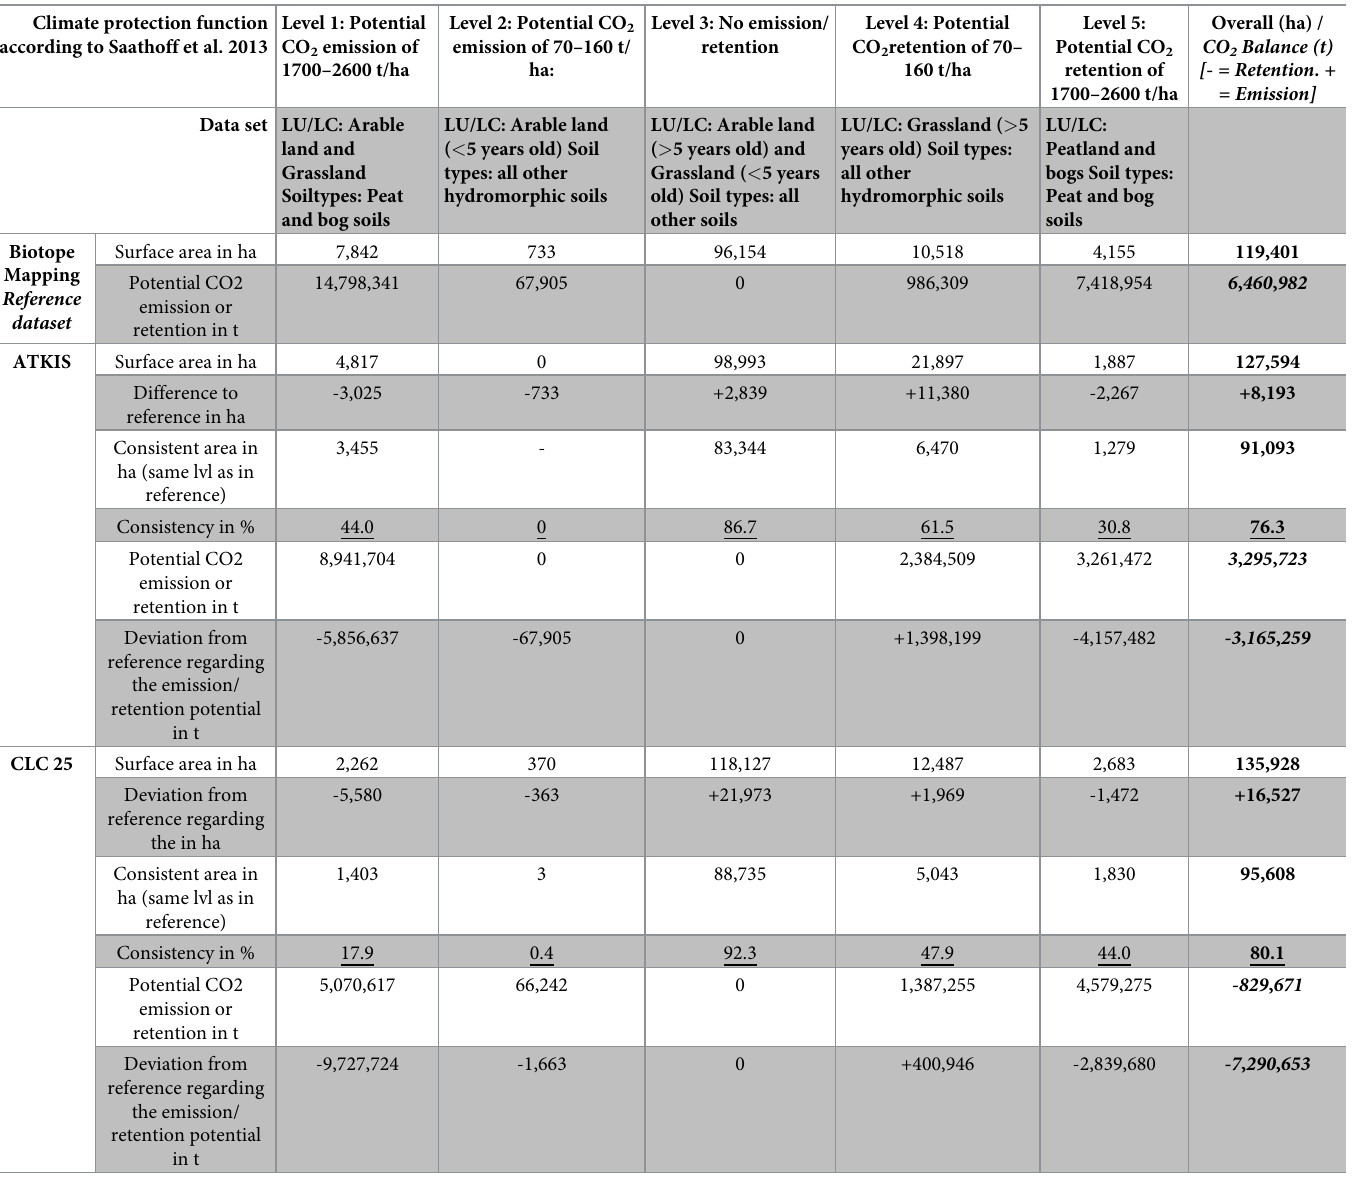
Table 2. Quantitative results of the case study ‘regional soil-based climate change mitigation’. Climate protection function Level 1: Potential according to Saathoff et al. 2013 CO 2 emission